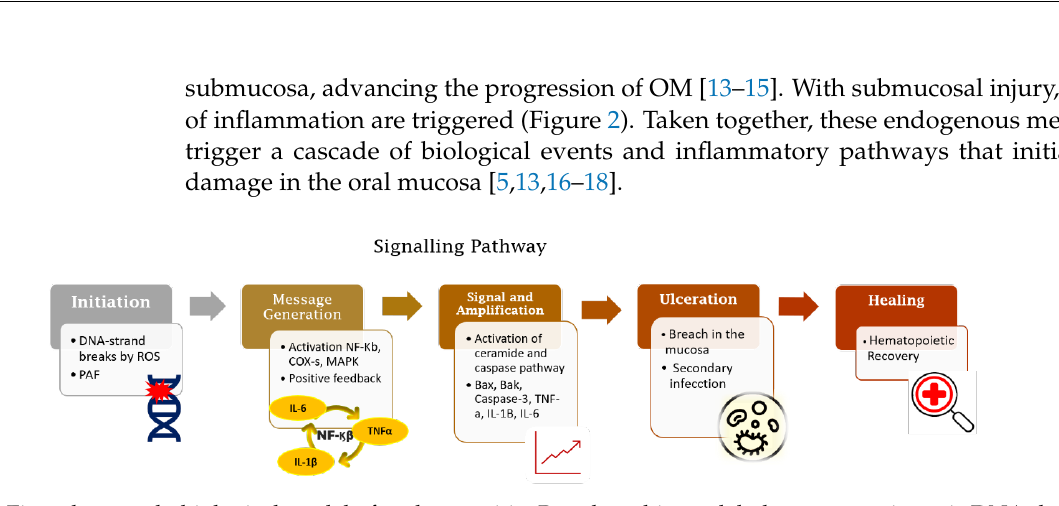
Figure 1. Five-phase pathobiological model of oral mucositis. Based on this model, the process